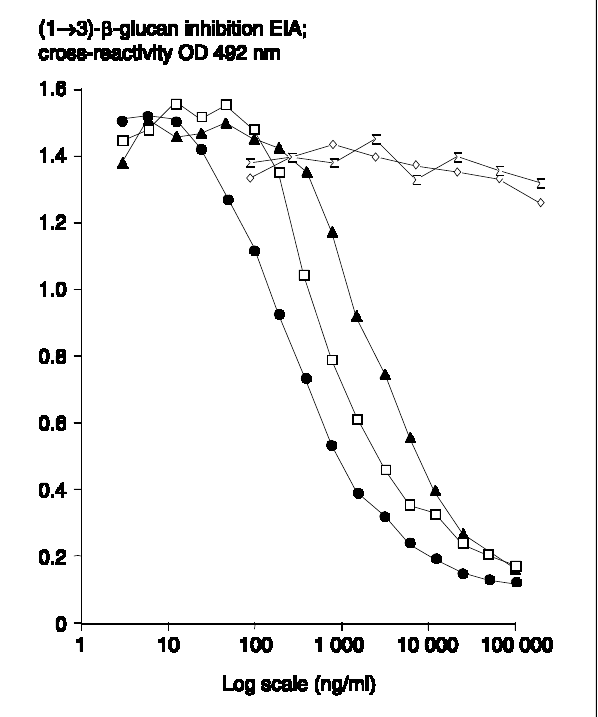
FIG. 1. Inhibition–dilution curves of four different glucans and mannan. Laminarin (closed circles) and CM-curdlan (open squares) are both (1 ® 3)- b -glucans, pustulan (closed triangles) is a (1 ® 6)- b - D -glucan contaminated with (1 ® 3)- b -glucan, dex- tran (open diamonds) is an a (1 ® 6)-glucan and mannan (crosses) is polymannose. EIA, enzyme immunoassay; OD, optical